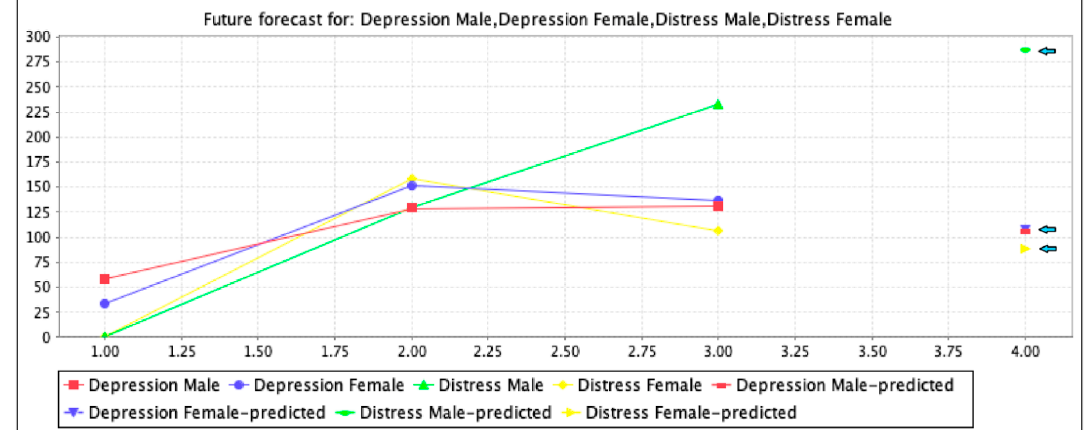
Figure 1. Forecast prediction of the analyzed population.